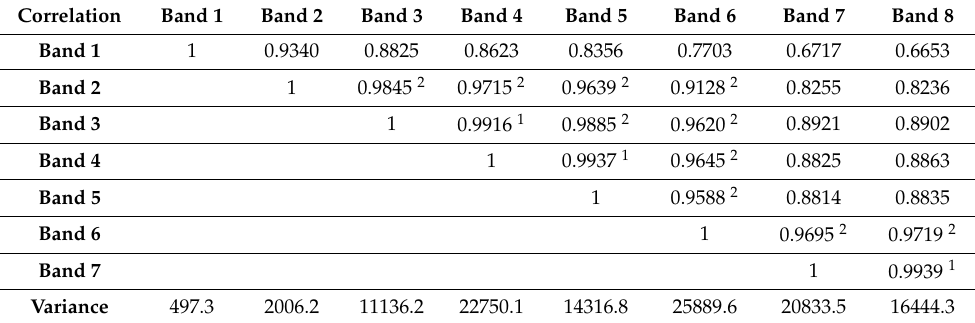
Table 4. Correlation of the WorldView-2 multispectral image